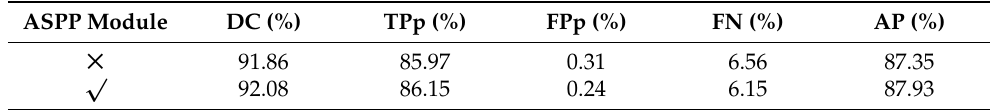
Table 2. The impact of ASPP module on network